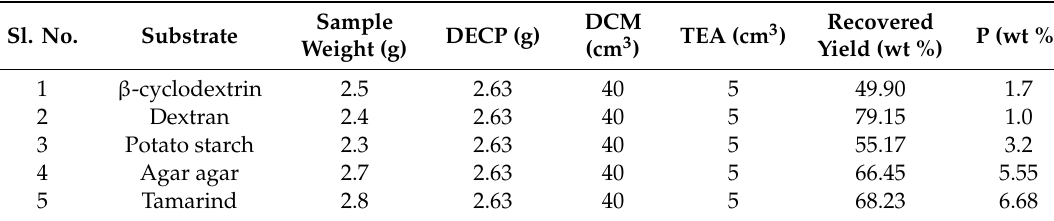
Table 1. Details of the chemical modification